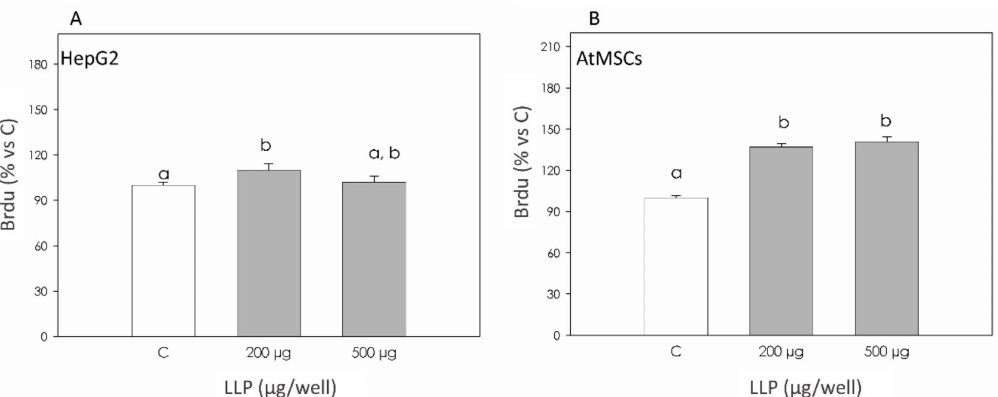
Figure 3. Evaluation of BrdU incorporation in HepG2 and At-MSCs after LLP treatment ( A ) HepG2: treatment with a suspension prepared with 200 µ g of LLP increased DNA synthesis ( p < 0.01), while 500 µ g/mL showed no difference in comparison to the control. ( B ) At-MSCs: both 200 and 500 µ g of LLP induced an increase in BrdU incorporation ( p < 0.001). Different letters indicate statistically significant